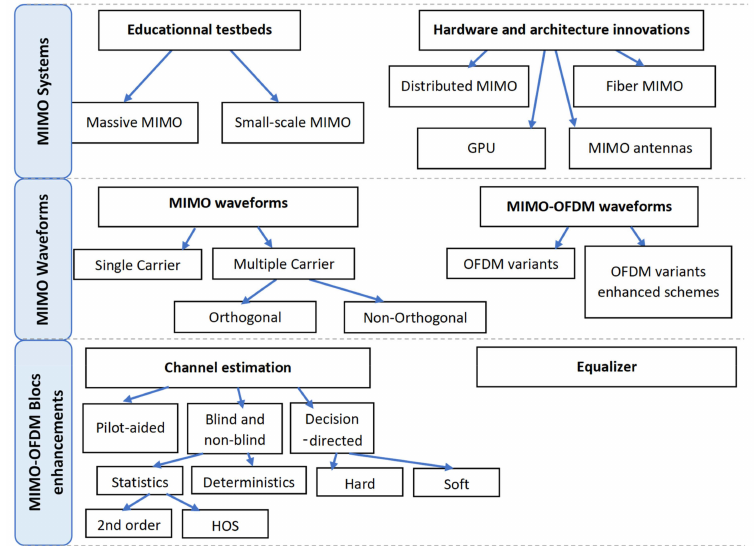
Figure 1. Overview of the discussed axes of the current review paper: in Section 3, three main axes will be analyzed: the MIMO systems’ recent hardware and architecture innovations, MIMO waveforms, and MIMO channel estimation and